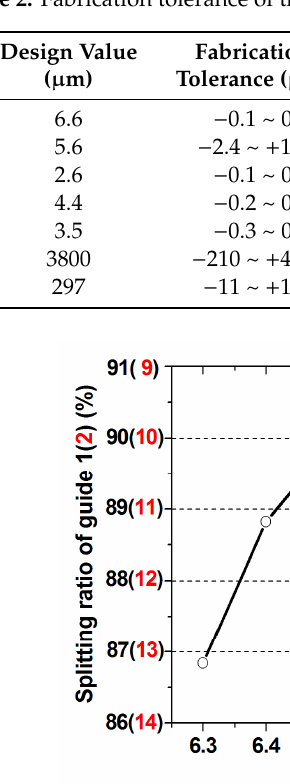
Table 2. Fabrication tolerance of the design parameters for 90:10 splitting ratio.